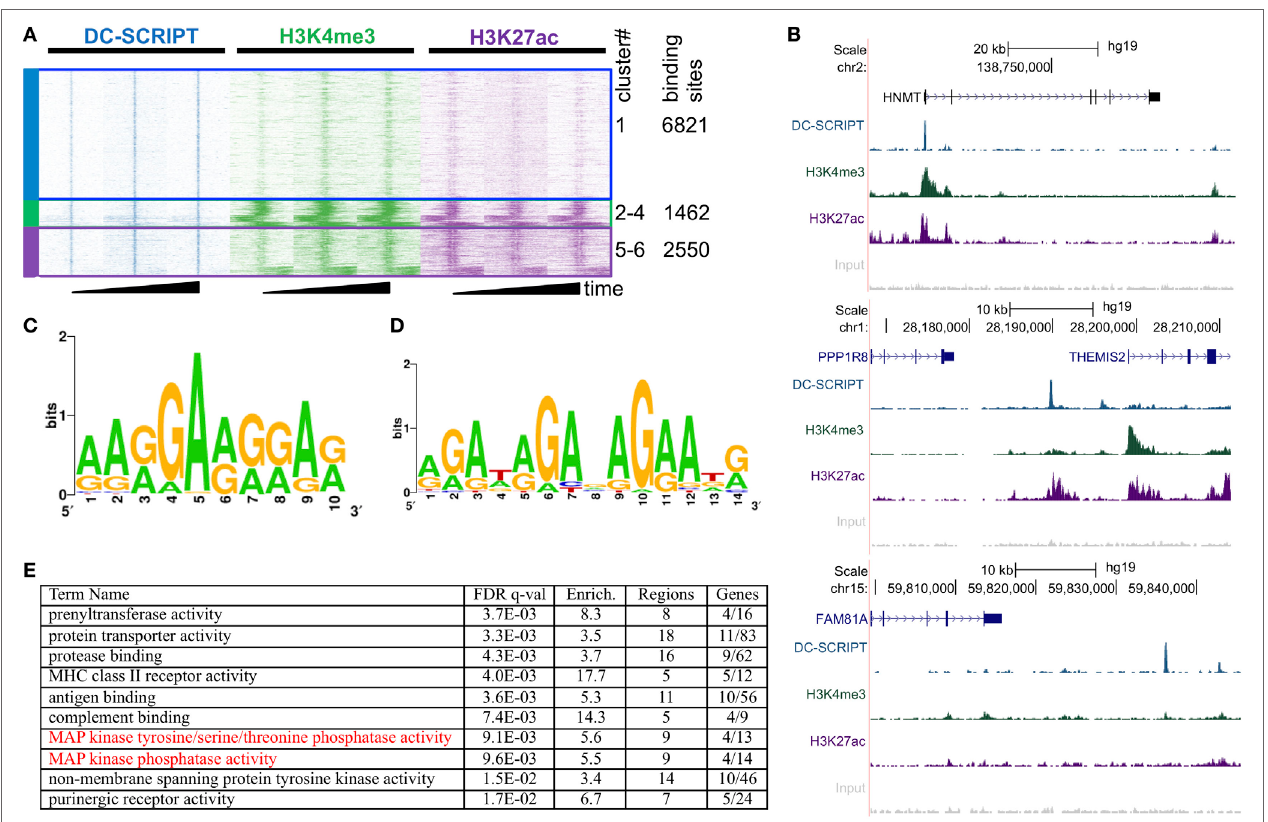
FigUre 1 | Genome-wide mapping of DC-SCRIPT binding sites in human dendritic cells (DCs). Chromatin immunoprecipitation sequencing (ChIP-Seq) of human immature or R848 (toll-like receptors 7/8 ligand)-activated DCs using DC-SCRIPT, H3K4me3, or H3K27ac Abs ( n = 3). (a) Heatmap of k -means clustering analysis ( k = 6, Euclidean distance) of DC-SCRIPT (blue), H3K4me3 (green), and H3K27ac (purple) in 10-kb windows around DC-SCRIPT peak summits. Clusters 2–4 are merged into an enhancer-associated cluster; clusters 5–6 are merged into a promoter-associated cluster. The rows correspond to the peaks; the x -axis shows the position relative to the peak center. The intensity of the color represents the number of reads in 100-bp windows. (B) Representative UCSC Genome Browser tracks of a PA-SC binding site (top), an EA-SC binding site (middle), and a no mark binding site (bottom). The tracks from top to bottom show the gene annotation, the ChIP-Seq signal for DC-SCRIPT (blue), H3K4me3 (green), H3K27ac (purple), and input (gray). (c) de novo motif generated from DC-SCRIPT ChIP-Seq binding sites. (D) In vitro motif identified by cyclic amplification and selection of targets. (e) Genomic Regions Enrichment of Annotations Tool analysis of all DC-SCRIPT- binding sites containing the GA-rich motif. The table contains the top 10 most significant terms in the gene ontology category molecular function. See also Figure S1 and Tables S1 and S2 in Supplementary